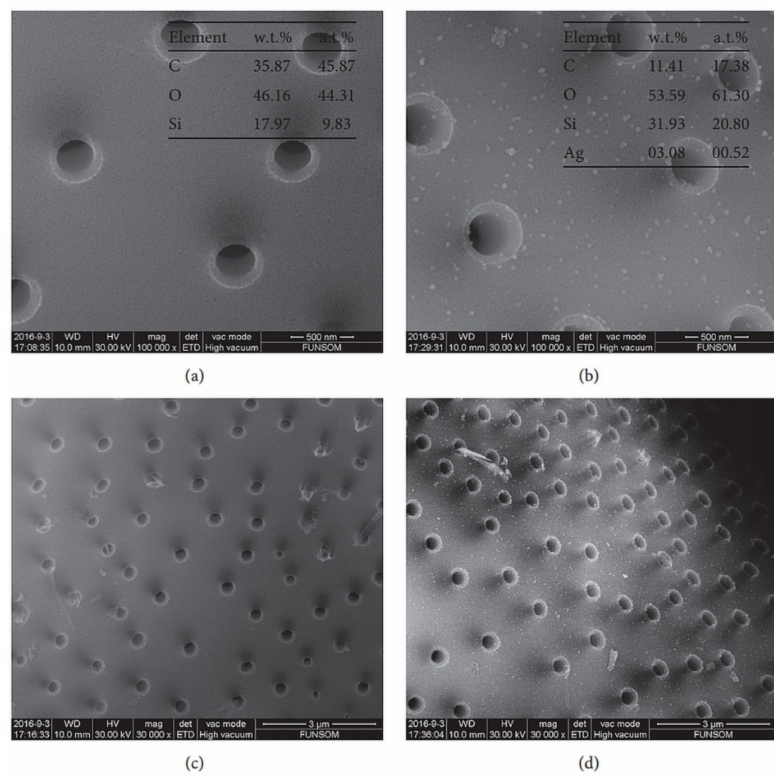
Figure 4. Scanning electron microscopy (SEM) images at di ff erent magnifications: ( a , c ) of the diatomite; ( b , d ) of the nanosilver-modified diatomite (nAgDT). Corresponding energy-dispersive X-ray spectroscopy (EDS) results are shown in ( a , b ). Reproduced from [61], copyright (2018), Hindawi, licensed under CC BY